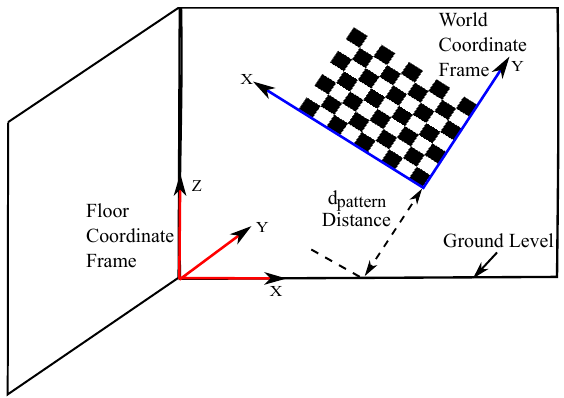
Figure 5. Schematic view of possible orientation of the world coordinate